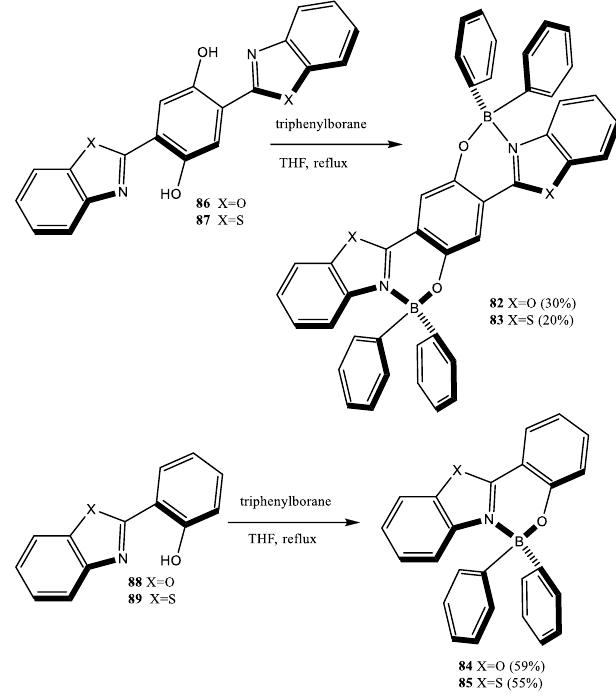
Scheme 18. Synthetic routes to the boron complexes 82 – 85 .